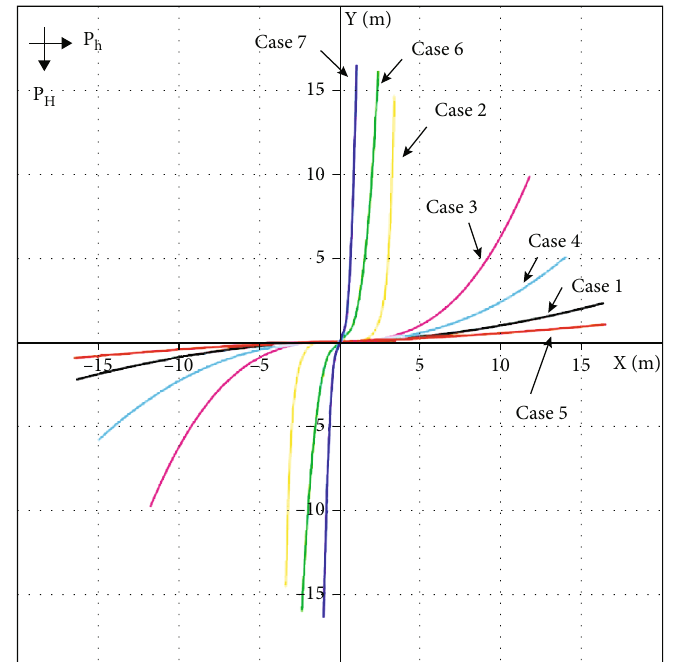
Figure 4: Morphology of hydraulic fracture with di ff erent